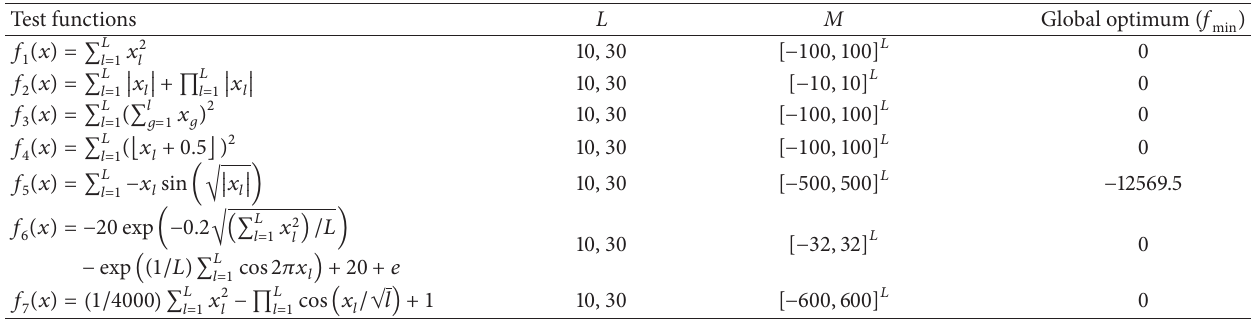
Table 2: Benchmark